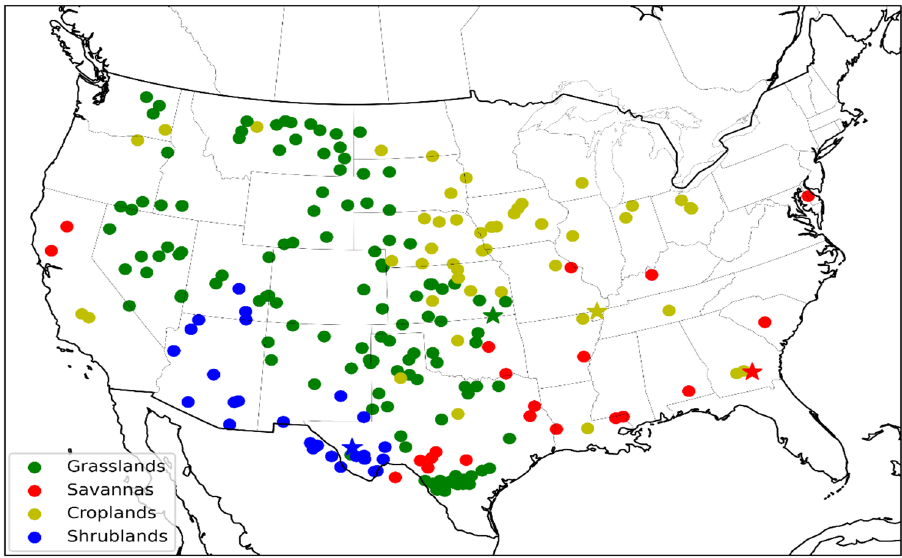
Figure 1. Spatial distribution of selected terrestrial study sites and their correspondent dominant landcovers (stared locations are representative sites of each landcover as shown in Figures